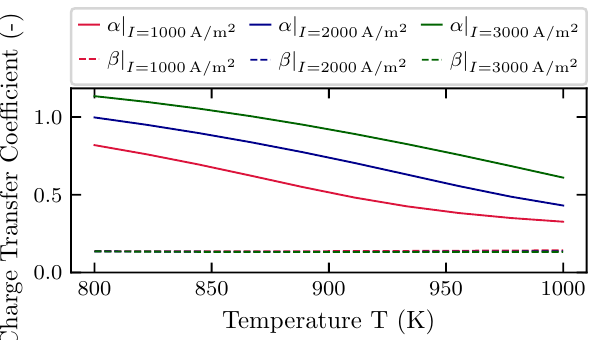
Figure 16. Charge transfer coefficients values proposed by the IMANN versus temperature. To see the improvement of the overall model, IMANN architecture is compared to the model with typically used charge transfer coefficient values. In the Figure 17 overpotential of the anode versus current density is presented for three different temperatures taken from the literature [56]. Experimental data points are marked as symbols, the standard model is represented as a dashed line, and the proposed method is represented as a solid line. It can be seen that for all data points—both training and test—hybrid model outperforms the classical model in terms of agreement with experimental measurements.